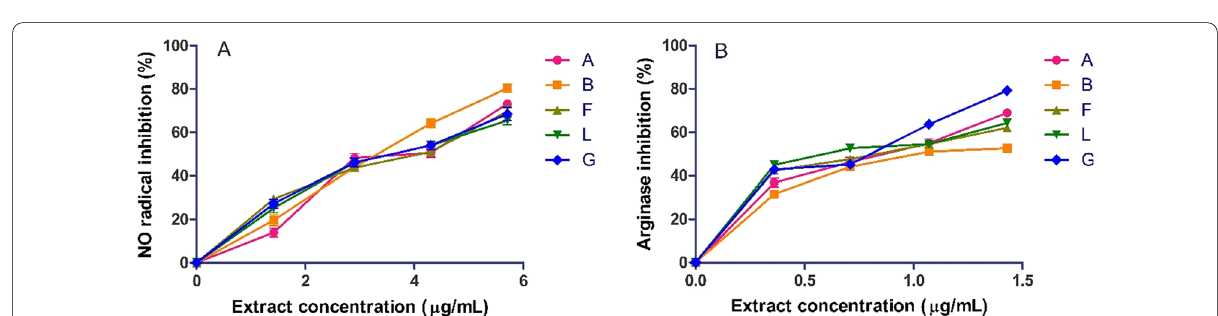
Fig. 3 Nitric oxide and L-arginase inhibitory activities of corn silk–lemon and commercial tea. A Nitric oxide inhibitory activity as described by Balakrishnan et al. (2009). The absorbance of the solution prepared was measured at 546 nm with a spectraMax plus UV–Vis microplate reader (Molecular Devices, GA, USA). The percentage scavenging was calculated and plotted against five samples extract concentration (ug/ml). B Evaluation of L-arginase. Arginase activity was determined by the measurement of urea produced by the reaction of Ehrlich’s reagent. The optical density reading was taken at 450 nm. The control experiment was performed without the test sample and the arginase inhibitory activity was expressed as percentage inhibition and plotted against five samples extract concentration (ug/ml). (Kaysen and Strecker 1973). A: 100% CSF; B: 95% CSF and 5% LF; F: top tea; L: lipton tea; G: green tea; CSF: corn silk flour; LF: lemon